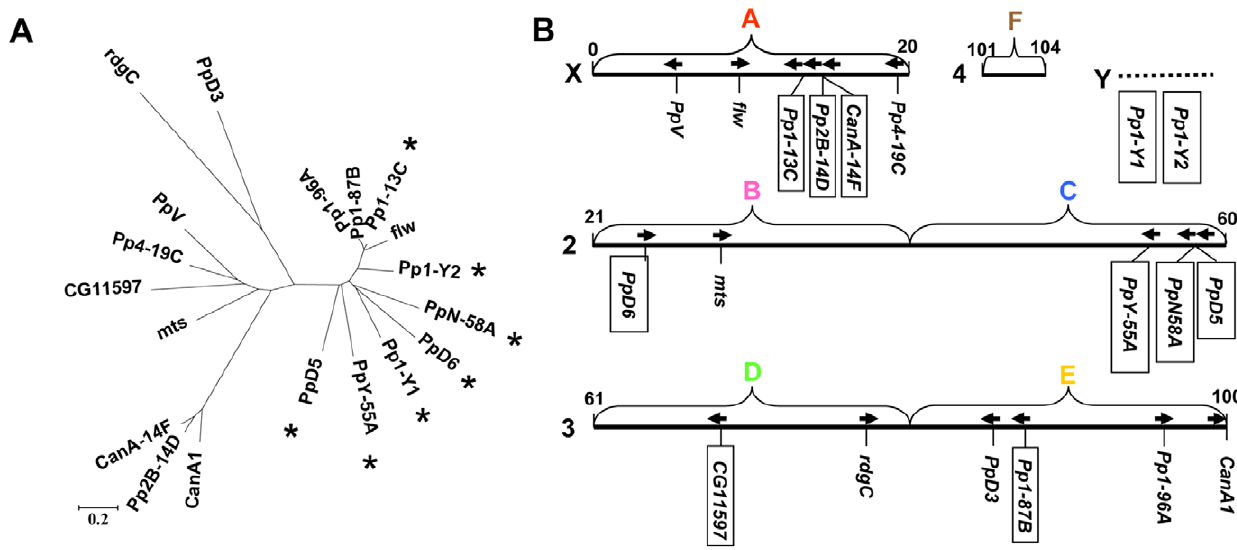
Figure 1. Phosphoprotein phosphatase (PPP) catalytic subunits of D.melanogaster . ( A ) Phylogenetic relationship of the amino acid sequences of 19 phosphatases. The bar indicates 0.2 amino acid substitutions per site, * labels male specific expression. ( B ) Chromosomal localization of the PPP genes. Chromosomes X, 2, 3, and 4 are depicted as solid bars with the numbering of the first and the last divisions. Chromosome Y is represented by an unproportional broken bar. The capital letters above the chromosomes label the chromosome arms termed the Muller elements. Although chromosome numbers vary in different Drosophila species the Muller elements are common to all species and can be conveniently used for the comparison of a gene’s global location. The directions of the ORFs are indicated by arrows (left to right corresponds to 5 9 to 3 9 in the upper strand). The genes that have no introns in their coding regions are boxed.